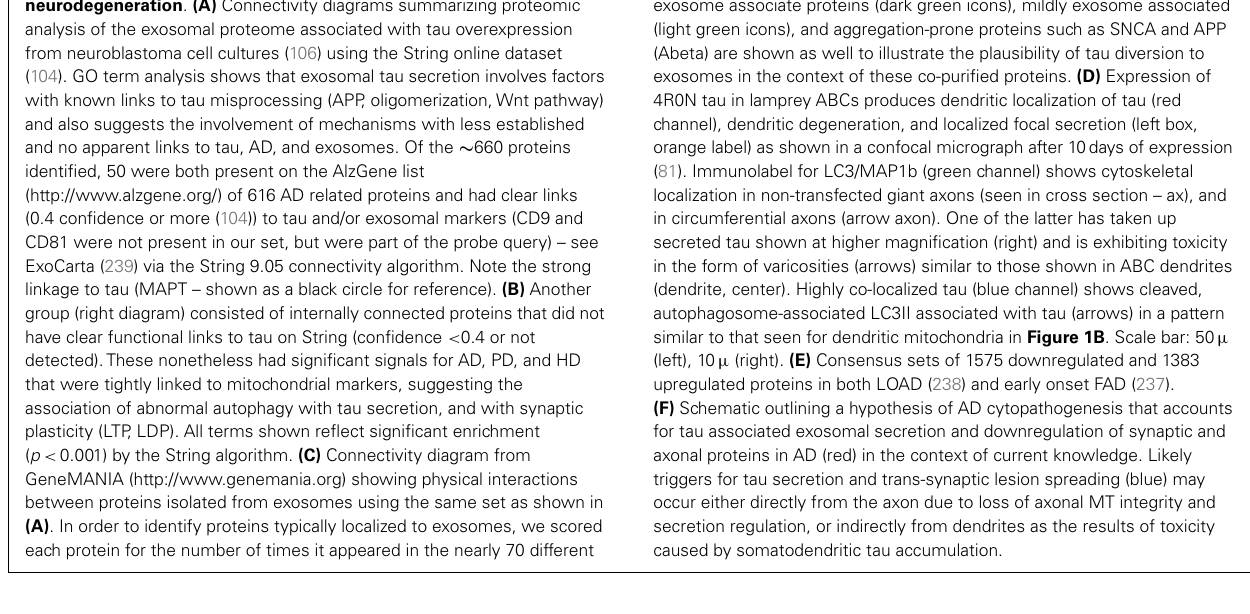
FIGURE 2 |The context of exosomal tau secretion and transneuronal neurodegeneration . (A) Connectivity diagrams summarizing proteomic analysis of the exosomal proteome associated with tau overexpression from neuroblastoma cell cultures (106) using the String online dataset (104). GO term analysis shows that exosomal tau secretion involves factors with known links to tau misprocessing (APP, oligomerization,Wnt pathway) and also suggests the involvement of mechanisms with less established and no apparent links to tau, AD, and exosomes. Of the ∼ 660 proteins identified, 50 were both present on the AlzGene list (http://www.alzgene.org/) of 616 AD related proteins and had clear links (0.4 confidence or more (104)) to tau and/or exosomal markers (CD9 and CD81 were not present in our set, but were part of the probe query) – see ExoCarta (239) via the String 9.05 connectivity algorithm. Note the strong linkage to tau (MAPT – shown as a black circle for reference). (B) Another group (right diagram) consisted of internally connected proteins that did not have clear functional links to tau on String (confidence < 0.4 or not detected).These nonetheless had significant signals for AD, PD, and HD that were tightly linked to mitochondrial markers, suggesting the association of abnormal autophagy with tau secretion, and with synaptic plasticity (LTP, LDP). All terms shown reflect significant enrichment ( p < 0.001) by the String algorithm. (C) Connectivity diagram from GeneMANIA (http://www.genemania.org) showing physical interactions between proteins isolated from exosomes using the same set as shown in (A) . In order to identify proteins typically localized to exosomes, we scored each protein for the number of times it appeared in the nearly 70 different